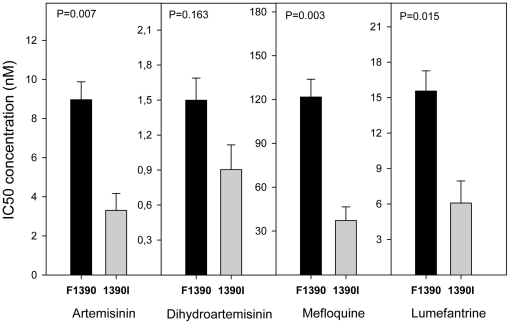
Significant association of pfmrp1 F1390I and IC50's for ART, MQ and LUM.Significant relationship between average in vitro drugs tested IC50's and pfmrp1 F1390I polymorphism. Data described in Table S2. Black bars are average IC50 of 36 isolates with F1390 allele. Grey bars are average IC50 of 8 isolates with 1390I allele. T-test statistics was applied. P value <0.0042 is consider significant after Bonferroni correction. Error bars represent SE.